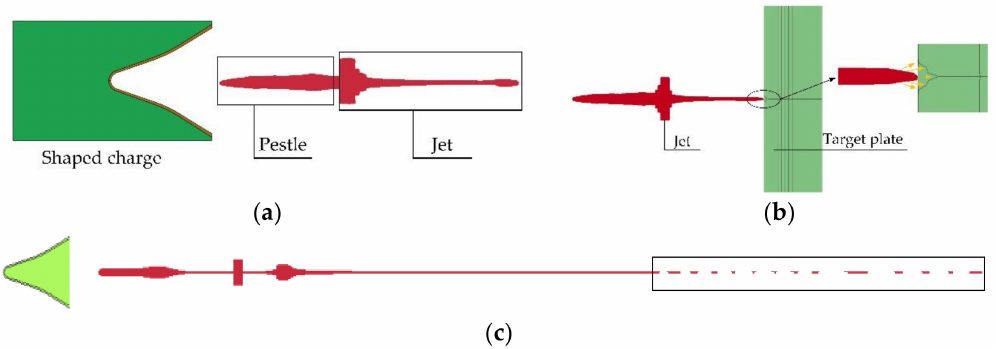
Figure 12. Jet penetration process. ( a ) The formation model of shaped charge jet; ( b ) The head motion model of shaped charge jet; and ( c ) The fracture model of shaped charge